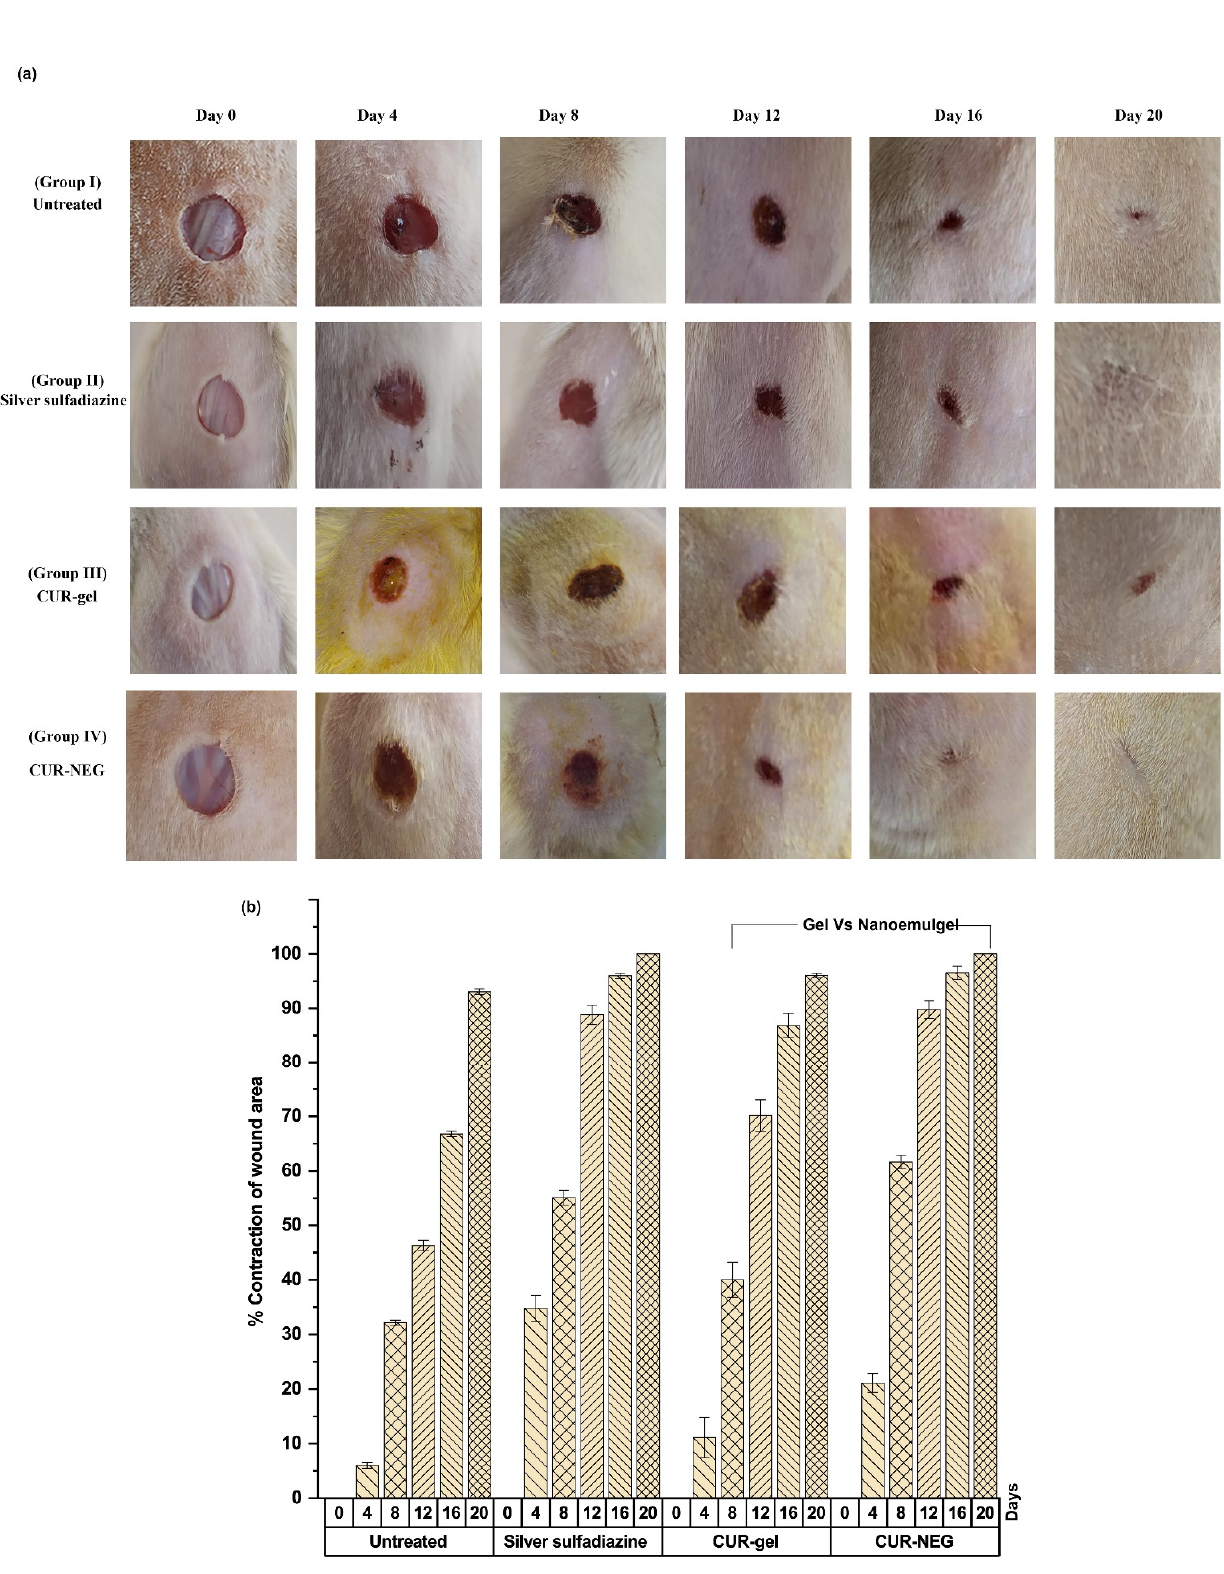
Figure 6. Illustration highlights improved wound healing efficacy of curcumin utilizing nanoemulgel as a delivery vehicle in Wistar rats. ( a ) Wound healing efficacy of curcumin nanoemulgel compared to the control, a marketed product, and curcumin-containing conventional gel. ( b ) Percentage of contraction of wound area of curcumin nanoemulgel compared to the control, a marketed product, and curcumin-containing conventional gel. Reproduced from [79], MDPI, 2021.